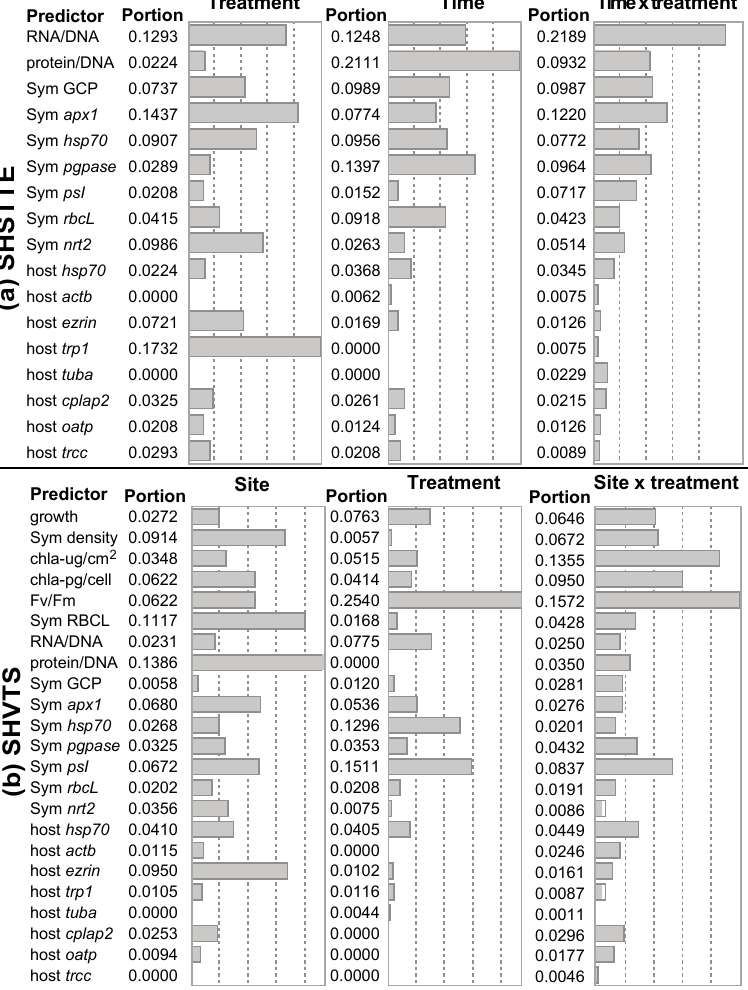
Figure 4. Predictor screening analysis of the Seriatopora hystrix short-term temperature experiment (SHSTTE) and the S. hystrix variable temperature study (SHVTS). The predictor screening function of JMP was used to determine the response variables that accounted for the greatest proportions of the cumulative differences between temperature, time, and their interaction in the SHSTTE (17 response variables; ( a )) and between temperature regime, site of origin, and their interaction in the SHVTS (23 response variables; ( b )). It should be noted that the relative scales differ between the proportion plots.